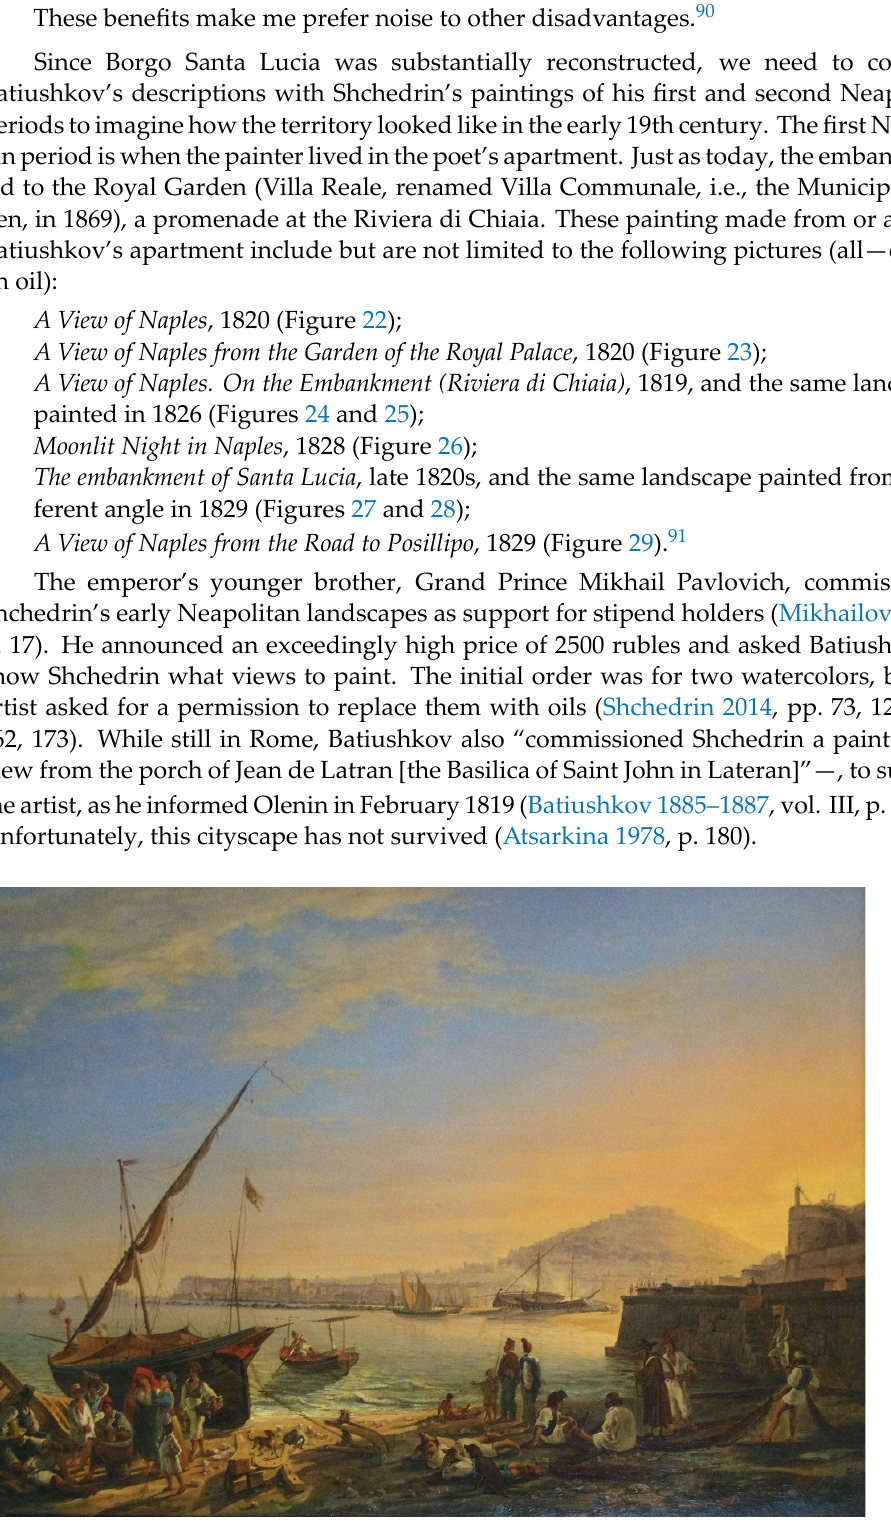
Figure 23. Sylvester Shchedrin. A View of Naples from the Garden of the Royal Palace , 1820. State Russian Museum, Saint Petersburg.